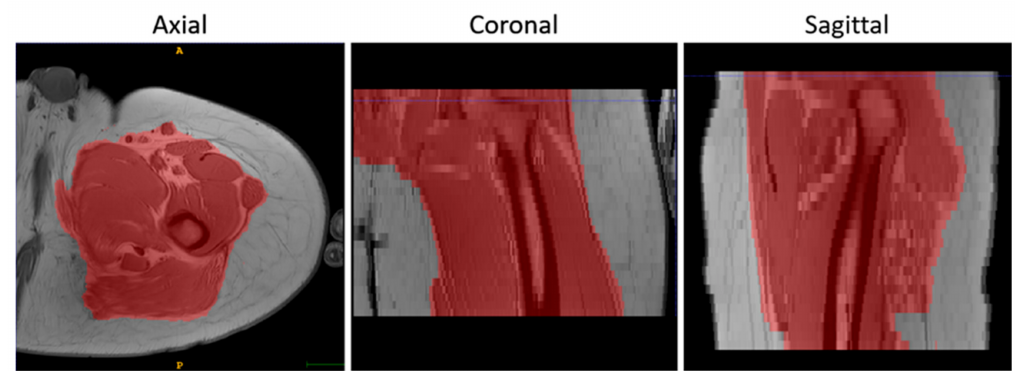
Figure 2. An example of the results of the masking step on T1-w MR images in 3 orthogonal